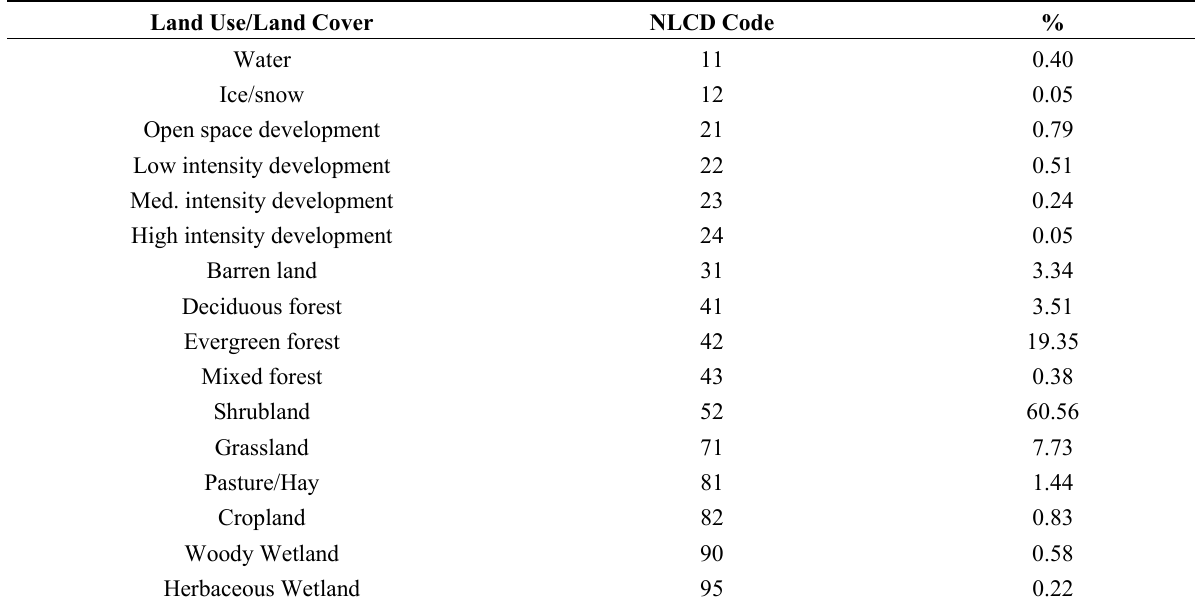
Table 1. Land use/land cover distribution within the study area based on National Land Cover Database [24].